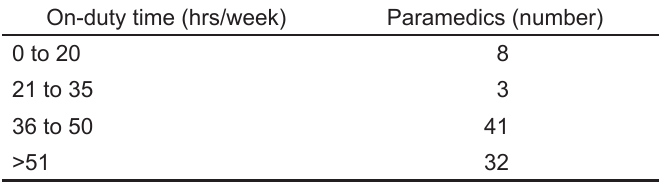
Table 2. Respondent experience